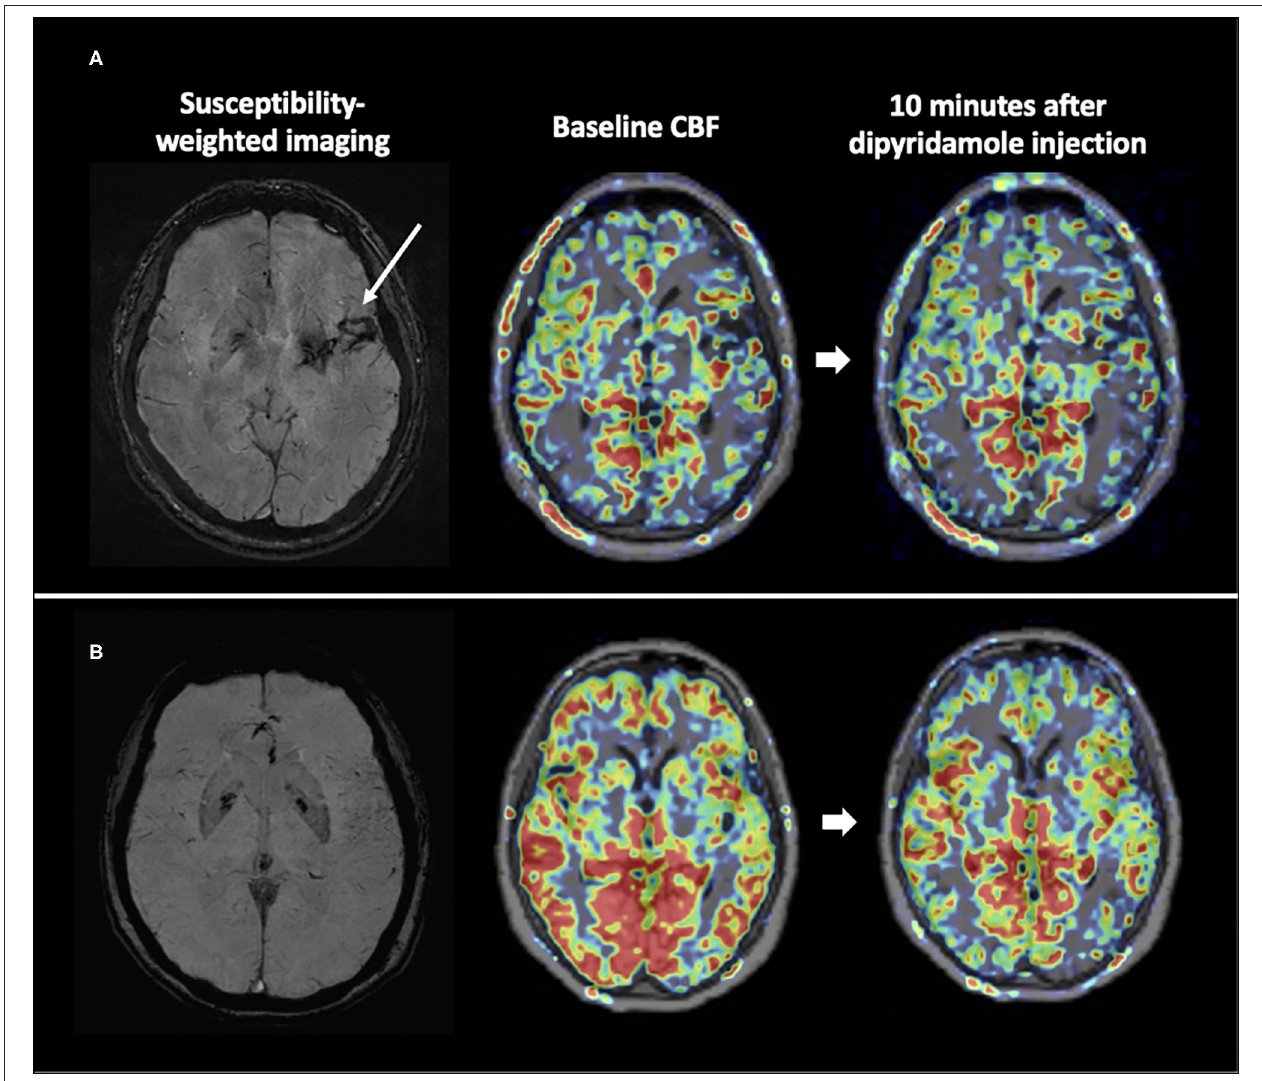
FIGURE 1 | CVR maps from representative subjects. The ICH patient (A) had little reduction in CBF after vaso-constrictive challenge compared to the healthy counterpart (B) .